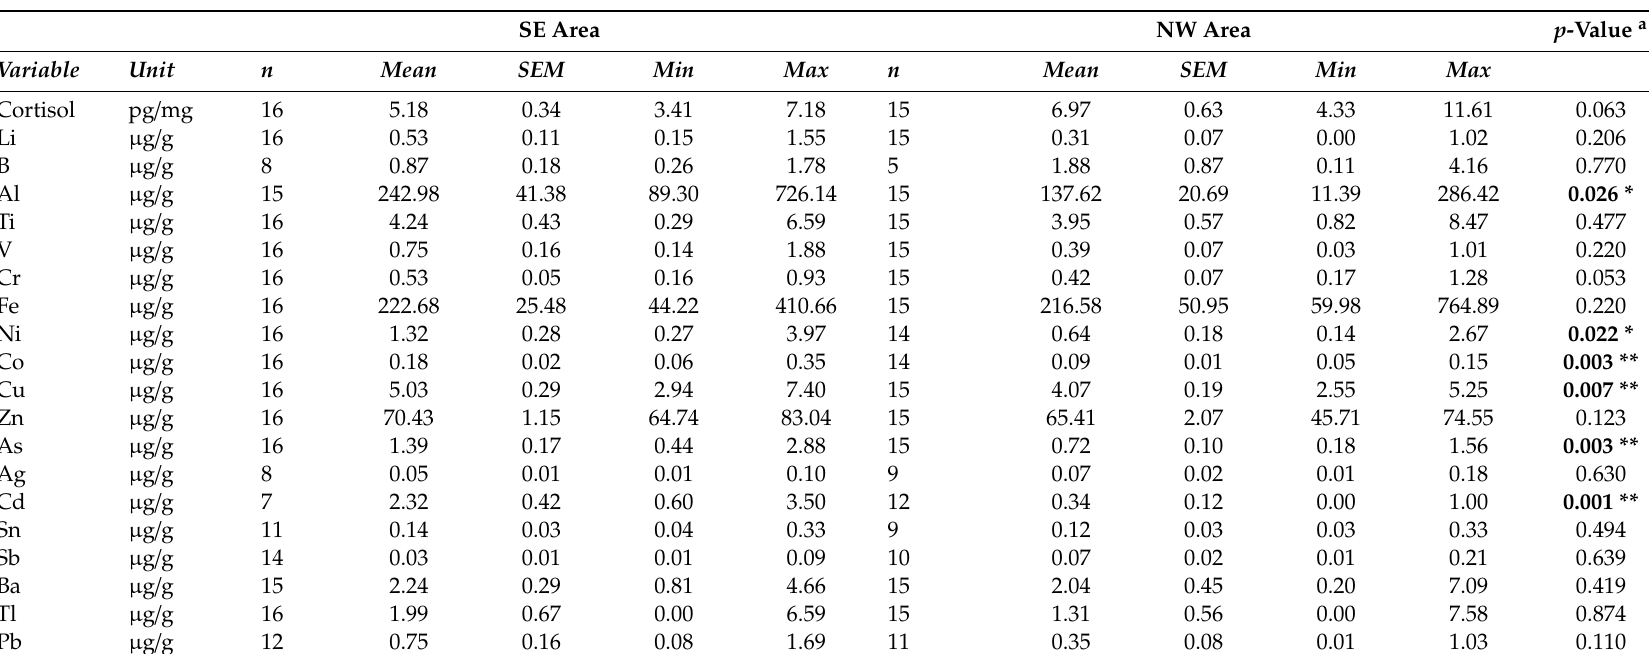
Table 1. Number of animals, means, standard errors (SEM), minimum (Min) and maximum (Max) values of cortisol and mineral hair concentrations in each geographic area of Stelvio National Park (South East, SE and North West, NW). Significant di ff erences (Mann–Whitney test) are highlighted in bold. SE